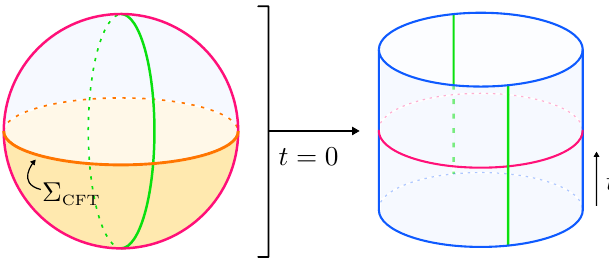
Figure 14 . A timeslice of our d -dimensional CFT setup with entangling surface (cid:6) equatorial conformal defect (the green line). In the right panel, one dimension is suppressed relative to the left panel.